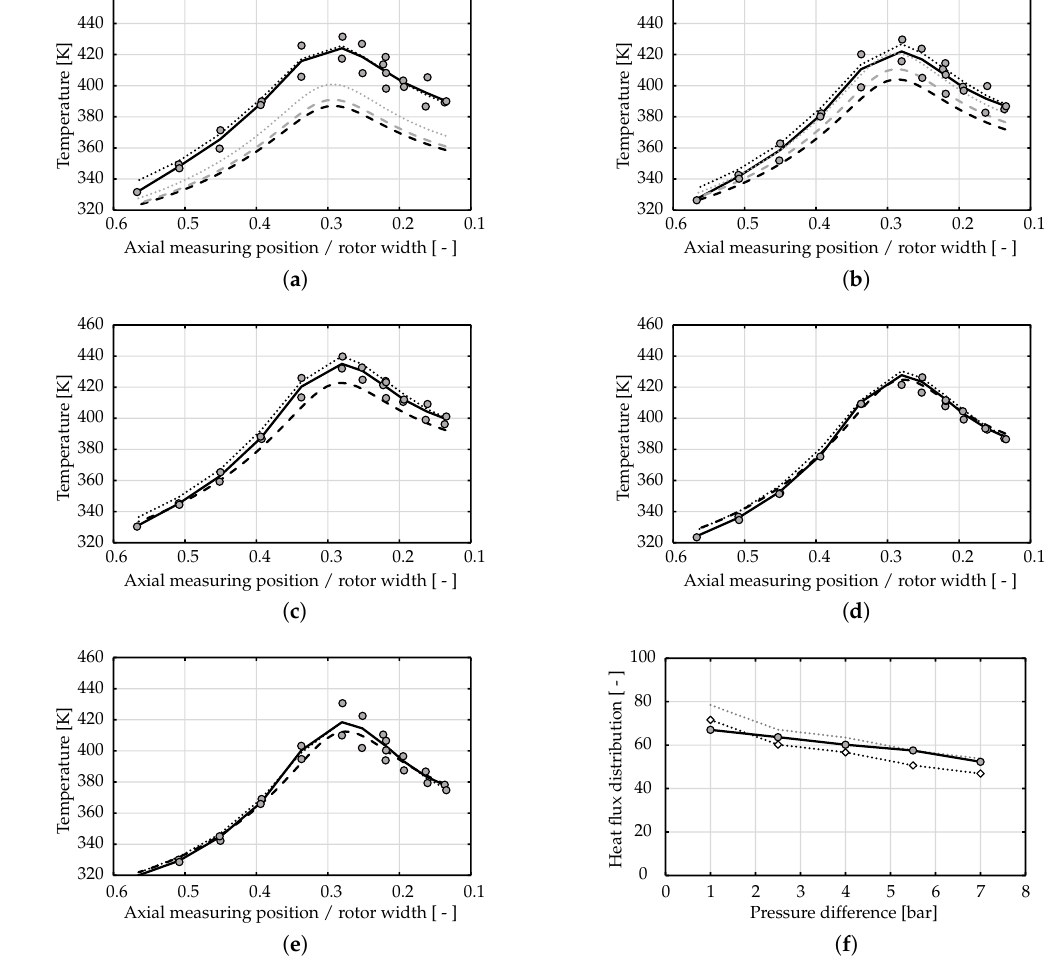
Figure 7. ( a – e ): Measuring points from experiment ( ), Fit of the measured values from experiment ( ), FE-Analysis ( ), CFD with α b = adjusted ( ), CFD with α b = 100W/ ( m 2 K ) ( ), CFD with α b = 1000W/ ( m 2 K ) ( ); ( f ): Heat flux distribution under variation of the pressure difference, Experiment ( ), CFD ( ), CFD (target) ( ), ( a ) ∆ p = 1.0bar, ( b ) ∆ p = 2.5bar, ( c ) ∆ p = 4.0bar, ( d ) ∆ p = 5.5bar, ( e ) ∆ p = 7.0bar. The findings from the comparison of the rotor temperatures are also well reflected by the differences in the heat flux distributions (see Figure 7f). The trend is quite well matched and the level of the heat flux distributions corresponds approximately to that of the experiment or FE analysis. Assuming that the slope of the experiment or FE analysis profile is correct, the heat flux distributions of the numerical simulation should follow the dotted line ( ). For this purpose, the values from the experiment or the FE analysis ( ) were transposed upwards until they corresponded to the value from the numerical simulation at the operating point with a differential pressure of 5.5 bar. This operating point was selected because the best agreement between numerical simulation and experiment was found there. If the dotted line ( ) is used as a comparison level, it becomes clear that too little heat is introduced into the rotor at low pressure differences in the case of numerical simulation. In the case of the additional calculations with heat transfer coefficients of α b = 100 W/ ( m 2 K ) or 1000 W/ ( m 2 K ) , this level ( ) is almost reached (not drawn in the diagram). However, other factors must also play a role, because, as shown above, the rotor temperatures are still calculated significantly too